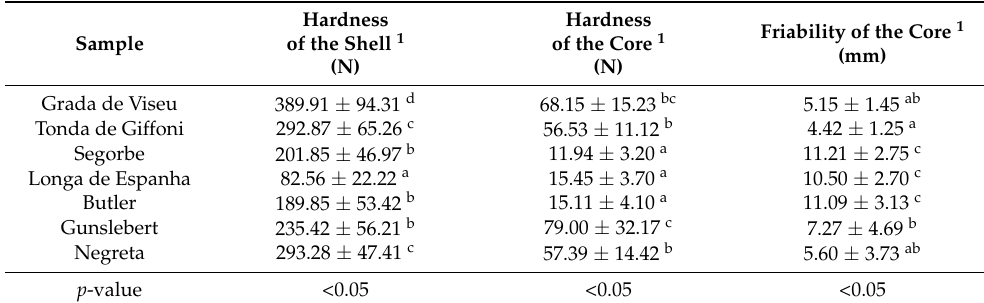
Table 5. Hazelnuts’ textural properties (mean ± standard